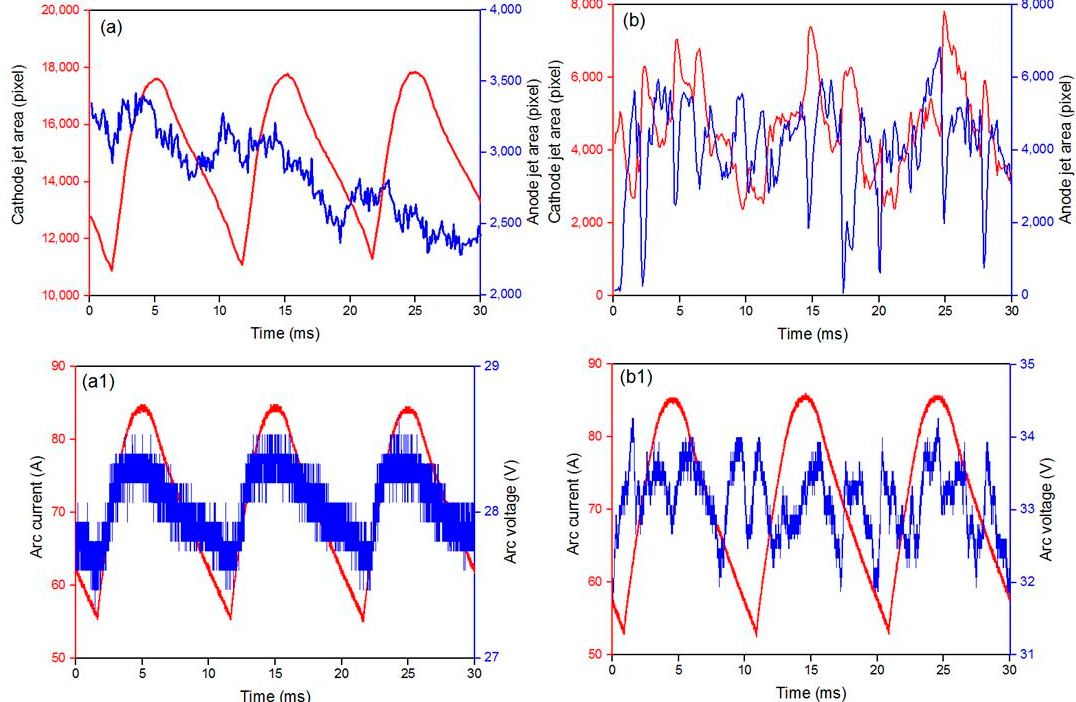
Figure 5. Waveform of anode/cathode jet area variation (upper) and synchronized arc current and voltage waveforms (lower) for argon arc with different hydrogen concentrations. ( a , a1 ) and ( b , b1 ) correspond to the hydrogen concentrations of 30 and 50 vol%, respectively.